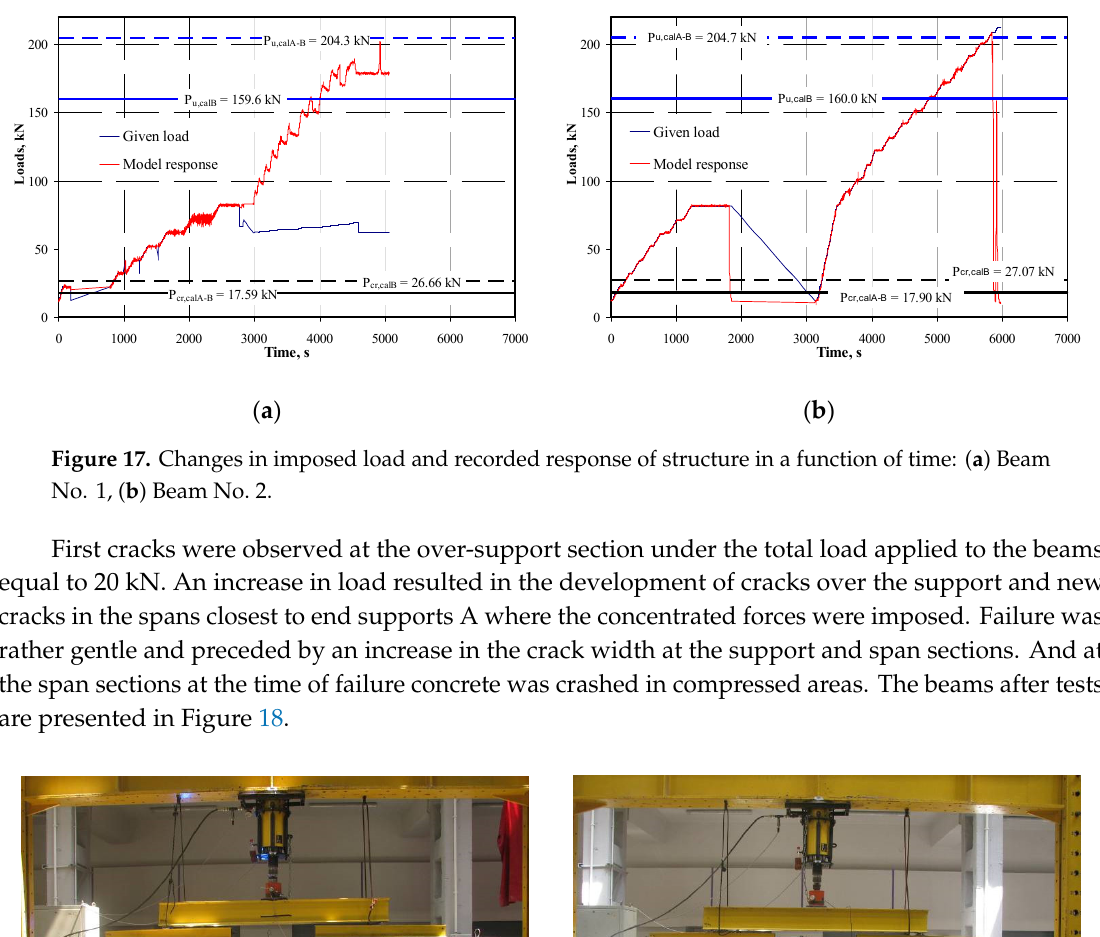
( d ) Figure 19. Deformations of beam sections at the time of cracking: ( a ) at the support section in Beam No. 1, ( b ) at the span section in Beam No. 1, ( c ) at the support section in Beam No. 2, ( d ) at the span section in Beam No. 2.